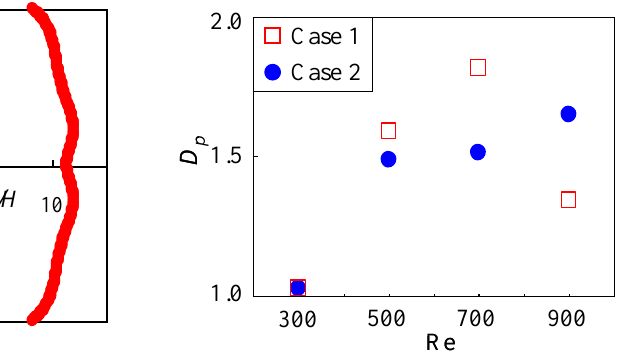
Fig. 13 Relation between the distortion parameter D and Re in case 1 and P